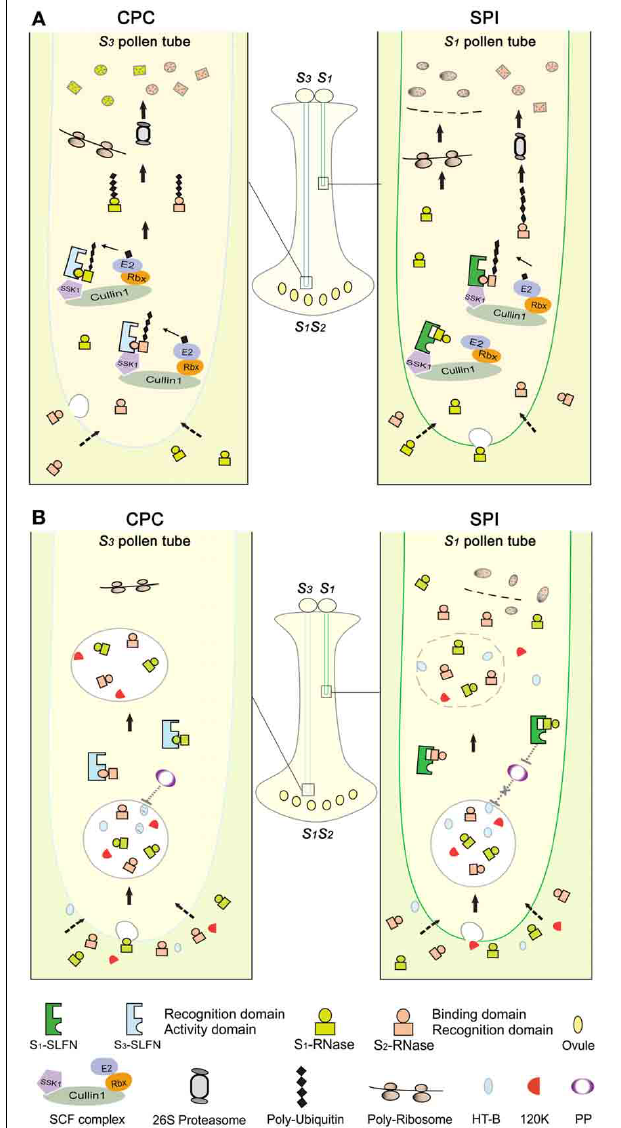
FIGURE 6 | Models of S-RNase-based self-incompatibility. (A) S-RNase degradation model in Petunia . In CPC response, cross S 3 pollen lands on the stigma, germinates and grows into an S 1 S 2 style. Both S 1 - and S 2 -RNases enter the S 3 pollen tube by endocytosis or an unknown pathway (dotted arrows). Subsequently, the hypothetical binding domains of S 1 - and S 2 -RNases interact with a hypothetical activity domain of the pollen S (i.e., SLF in Solanaceae and Plantaginaceae ) in the cytosol of the pollen tube. Then, one or more SLF (SLFN) in S 3 pollen tube form functional SCF S3 - SLFN complexes to tag S 1 - and S 2 -RNases with a polyubiquitin chain, which are subsequently degraded by the 26S proteasome. Thus, ribosomal RNAs escape from degradation by S-RNases in cross-pollen tubes, resulting in normal pollen tube growth. In SPI, during which self S 1 pollen lands on the S 1 S 2 style, both S 1 - and S 2 -RNases enter the S 1 pollen tube. Similar to CPC response, non-self S 2 -RNases bind to a hypothetical activity domain of the pollen S in the cytosol of the pollen tube. Then, one or more SLF (SLFN) in S 1 pollen tube form SCF S1 - SLFN complexes to tag S 2 -RNase